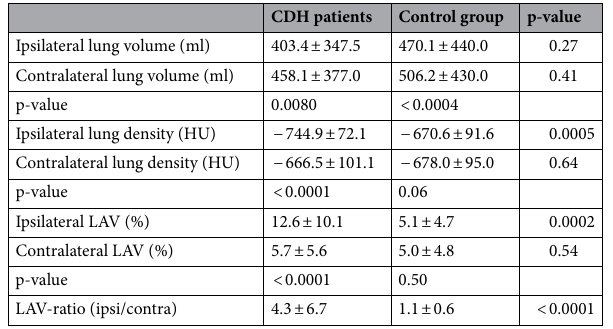
Table 1. Lung volume and emphysema indices of CDH patients and control group. HU Hounsfield unit, LAV low attenuating volume.